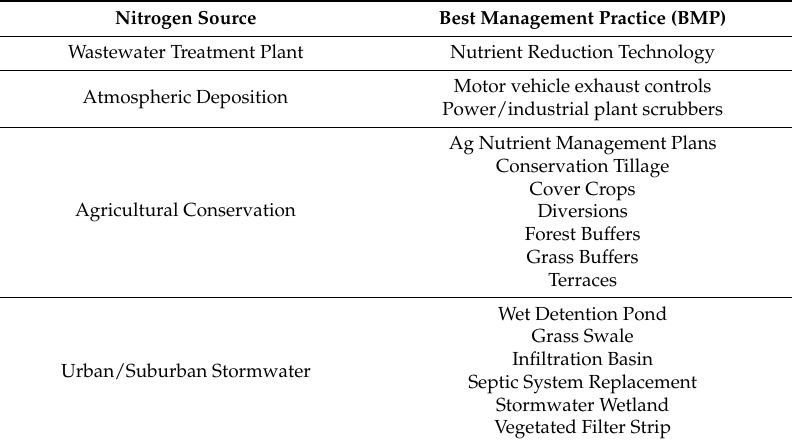
Table 4. Nitrogen reduction best management practices.